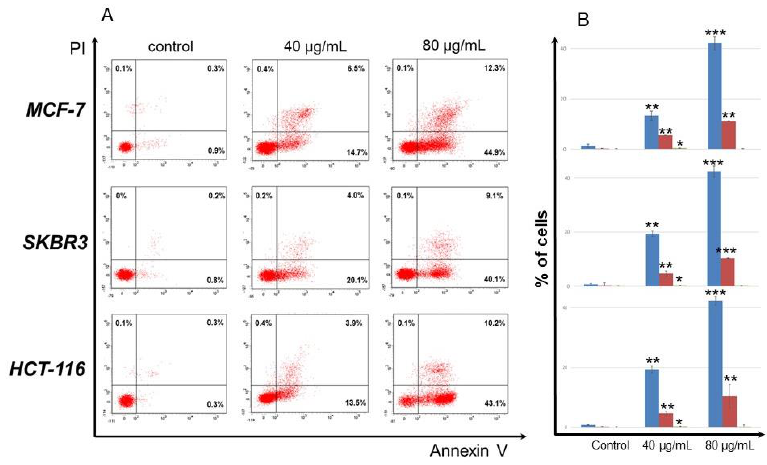
Figure 2. Compound 6 induced apoptosis to human cancer cells. MCF-7, SKBR3, and HCT-116 cells were exposed to 40 and 80 μg/mL of compound 6 for 72 h, stained with annexin V and PI, and analyzed by flow cytometry. Control cells were incubated in complete medium supplemented with 0.5% DMSO. Flow cytometry analysis was performed using FACS Diva software. ( A ). Representative dot plots from cells treated with compound 6 . Percentages of early apoptotic (lower right), late apoptotic/necrotic (upper right), and necrotic (upper left) are shown in each quadrat. ( B ). Histograms of apoptotic and necrotic cells after exposure to compound 6 . Blue columns show percentages of early apoptotic, red columns of late apoptotic and green columns of necrotic cells. Mean values ± SD from 3 experiments are shown. *, p < 0.05; **, p < 0.01; ***, p < 0.001, in all cases compared to control after Student’s unpaired Based on the significant cytotoxic activity of compound 6 against cancer cell lines we further tested whether it may also be toxic against normal cells, i.e., PBMCs isolated from two different t healthy blood donors. PBMCs were incubated for 24 h with the IC 50 and the 1/2 concentration of 6 , stained and analyzed by flow cytometry. Interestingly, the IC 50 of compound 6 (80 μg/mL) induced